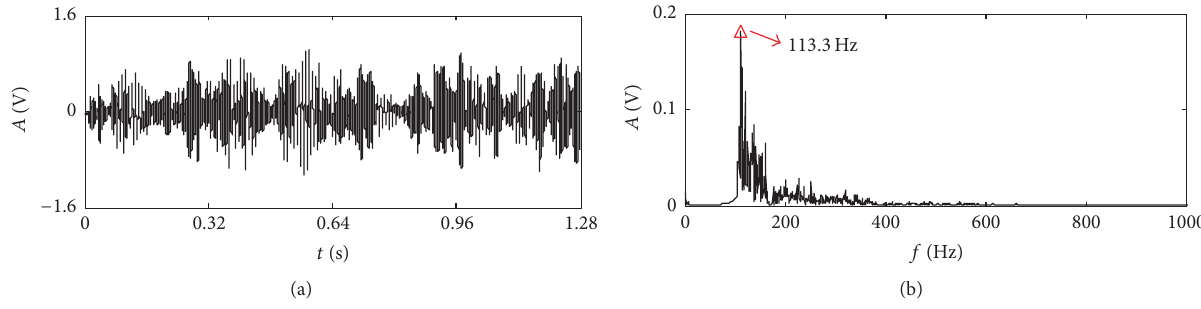
Figure 15: Detection results of the proposed method: (a) the output waveform of SR system; (b) the frequency